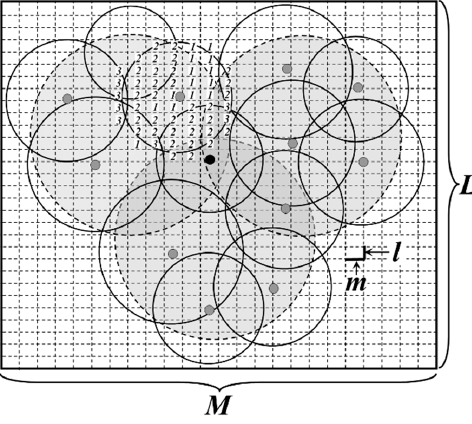
Figure 8. Overlapping sensing area judgment based on grids.